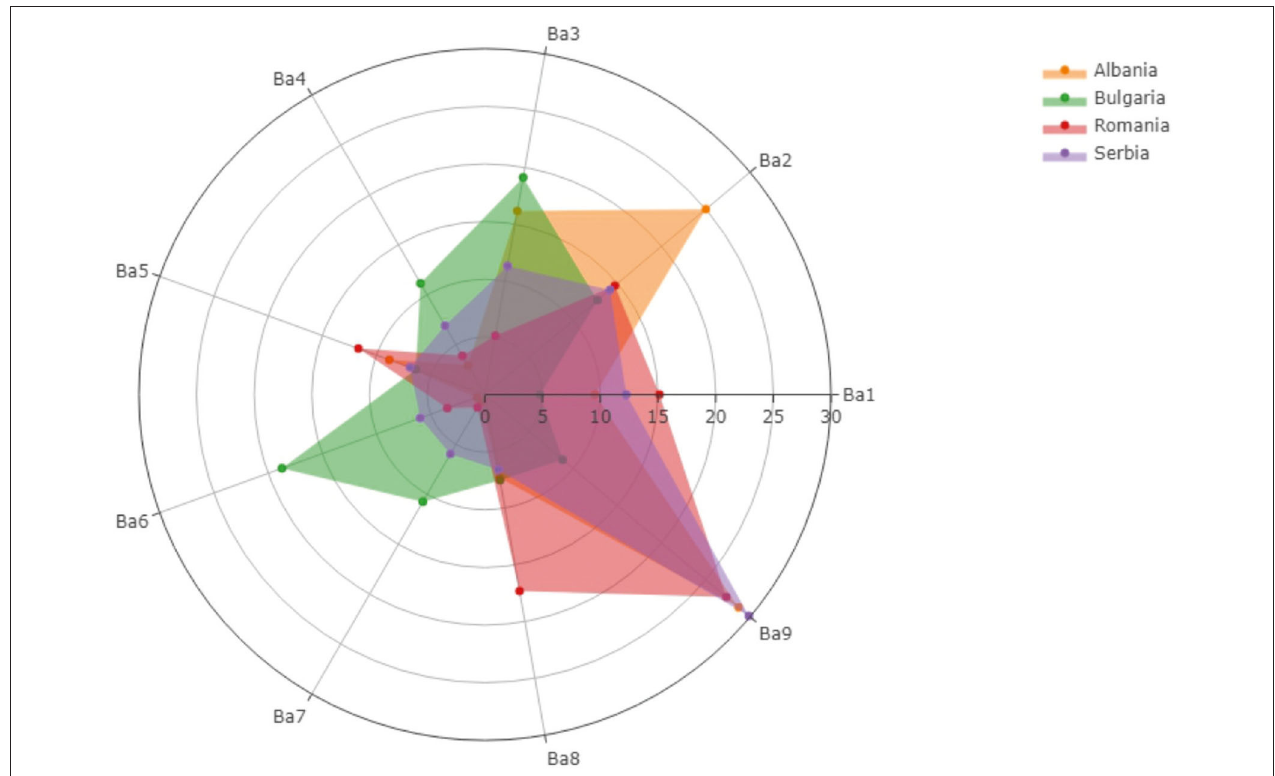
FIGURE 2 | The barriers that must be overcome through vaccination services provided in community